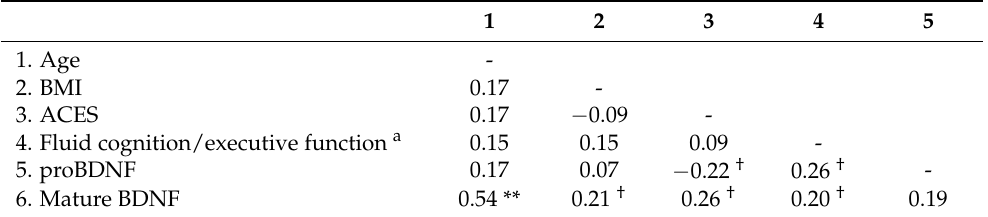
Table 2. Bivariate Correlations of Key Study Variables.